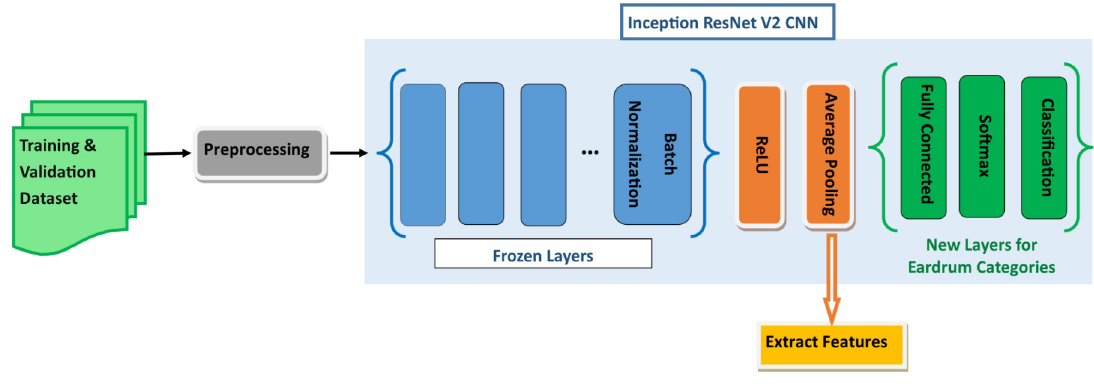
Fig 4. Block diagram of feature